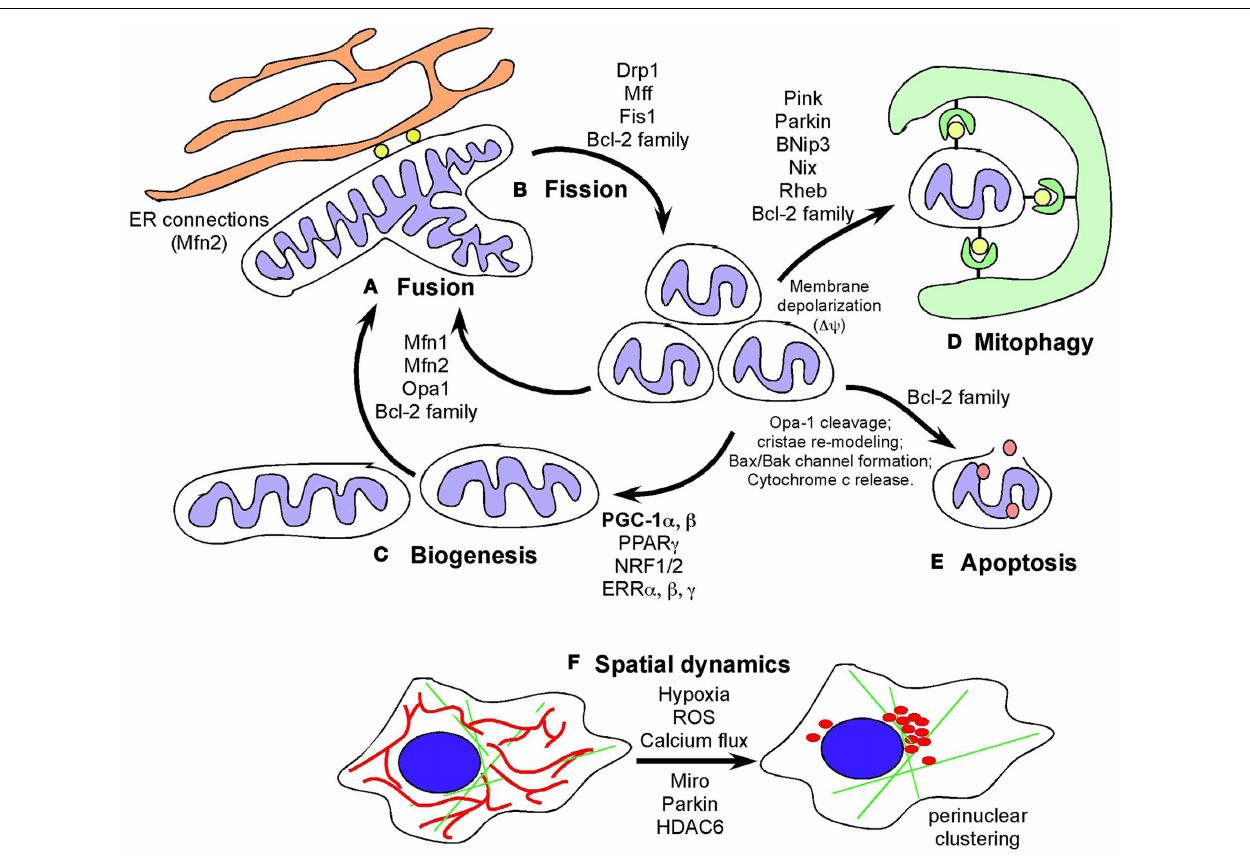
genes that are co-regulated by transcription factors NRF1/2, PPAR γ , ERR α , β , γ , and the key transcriptional co-factor, PGC-1 α . Mitochondrial biogenesis